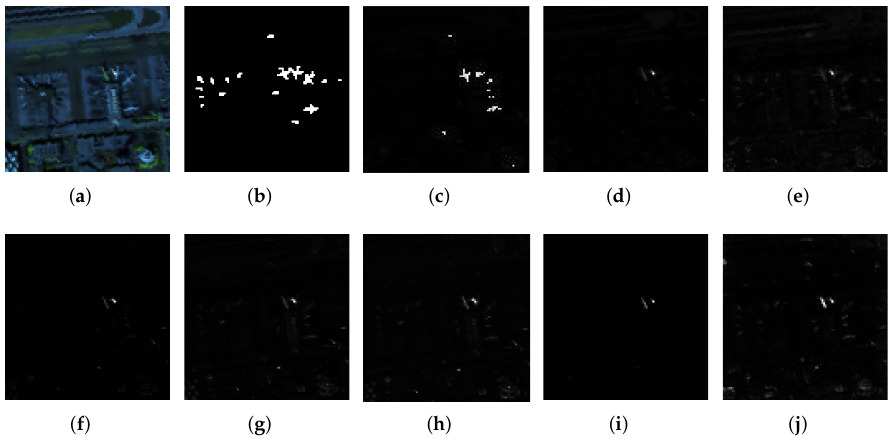
Figure 7. Visual detection results of all the algorithms on the Los Angeles dataset. ( a ) Pseudocolor